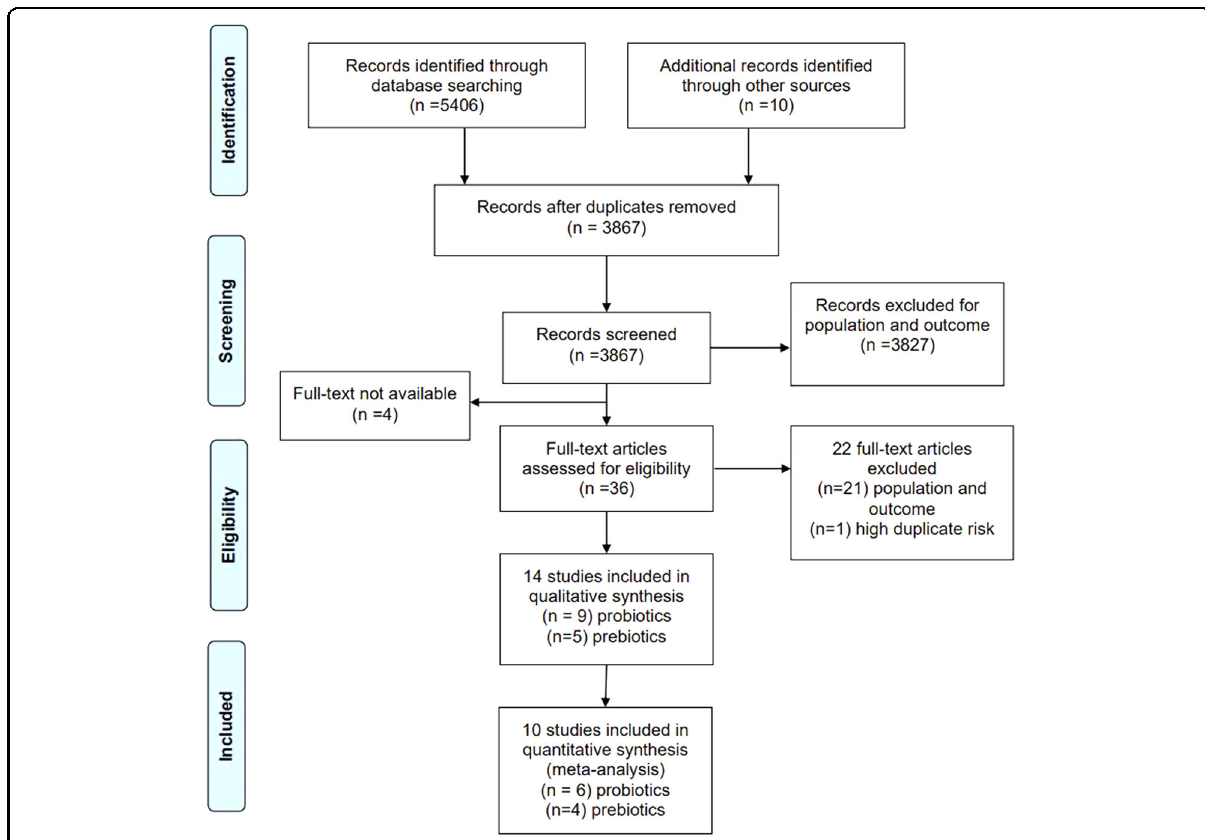
Fig. 2 PRISMA fl owchart of search results at each step of the systematic review. This illustarates the number of studies considered for inclusion and exclusion throughout the